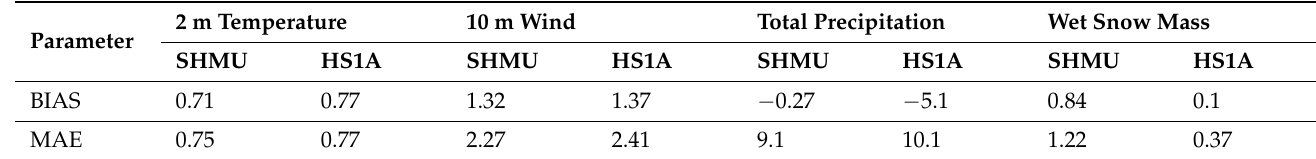
Table 8. The same as in Table 7, except for the 12–13 April 2021 snowfall.